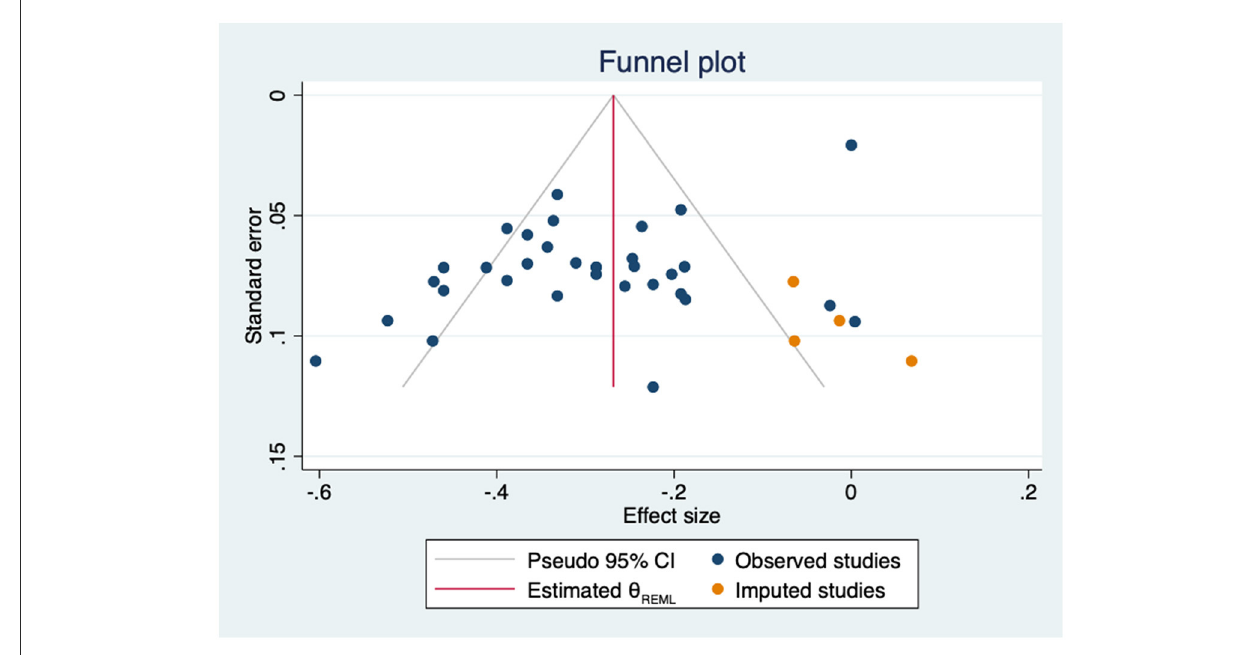
FIGURE6 Funnel plot with trim-and-fill imputations for the association between empowerment and depression.